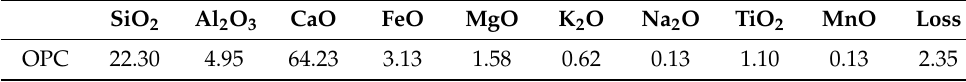
Table 1. Oxide compositions of cement (%).